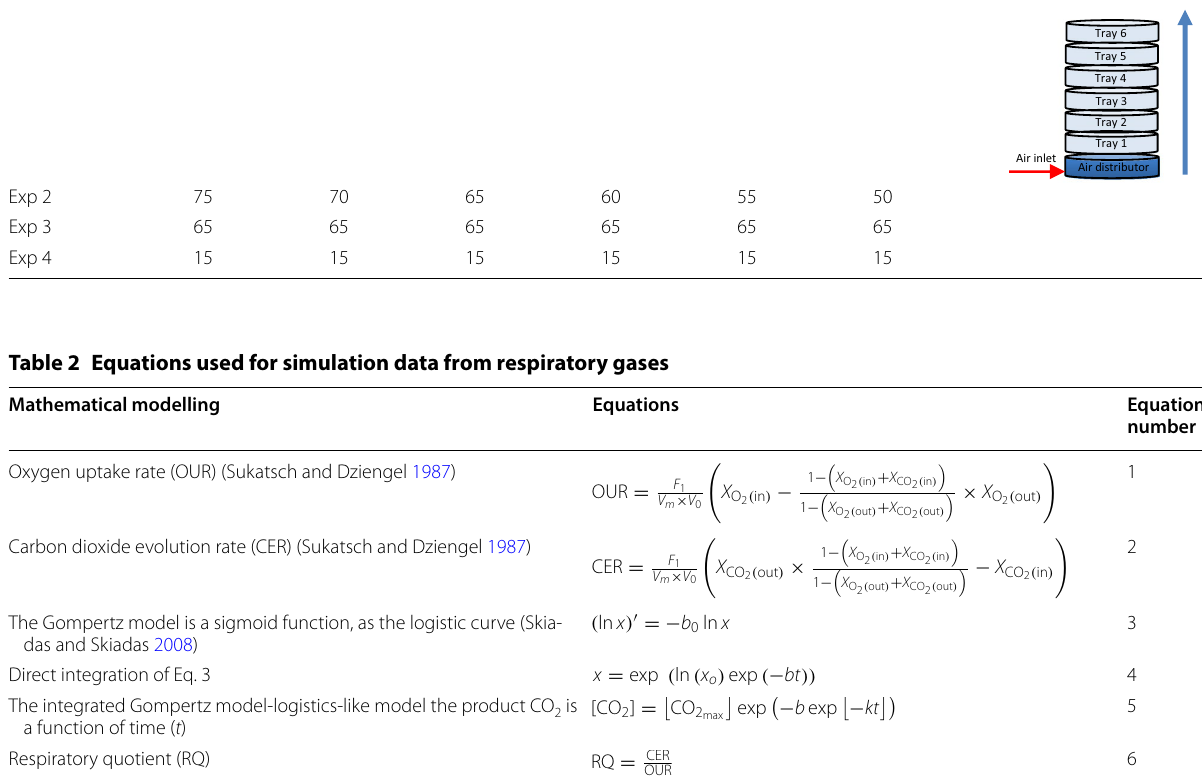
OUR, oxygen uptake rate (mole/L h); CER, carbon dioxide evolution rate (mole/L h); F 1 , air flow rate of inlet gas (L/h) at 1 atm and 30 °C; V m , molar volume of gases 24.88 L/mole at 1 atm and 30 °C; V 0 working volume solid phase (L); X O 2 ( in ) , molar fraction of oxygen at gas inlet; X O 2 ( out ) , molar fraction of oxygen at = gas outlet; X CO 2 ( in ) , molar fraction of CO 2 at gas inlet; X CO 2 ( out ) , molar fraction of CO 2 at gas outlet; x , the function of time; b 0 , a positive constant expressing the rate of growth of the system; (cid:31) CO 2 max (cid:30) , the maximum CO 2 concentration (at t > ) (mole); b , a constant related to the initial conditions (when t = 0 , then ∞ = (cid:31) CO 2 [CO 2 ] = (cid:31) CO 2 exp ( − b ) (dimensionless); k , the specific CO 2 evolution rate (h − 1 ); t , fermentation time (h), RQ, respiratory quotient (dimensionless) max (cid:30) 0 (cid:30)